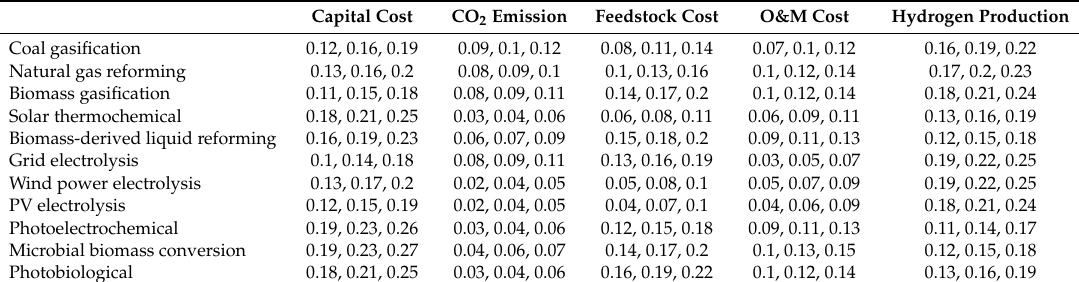
Table 8. Weighted fuzzy decision